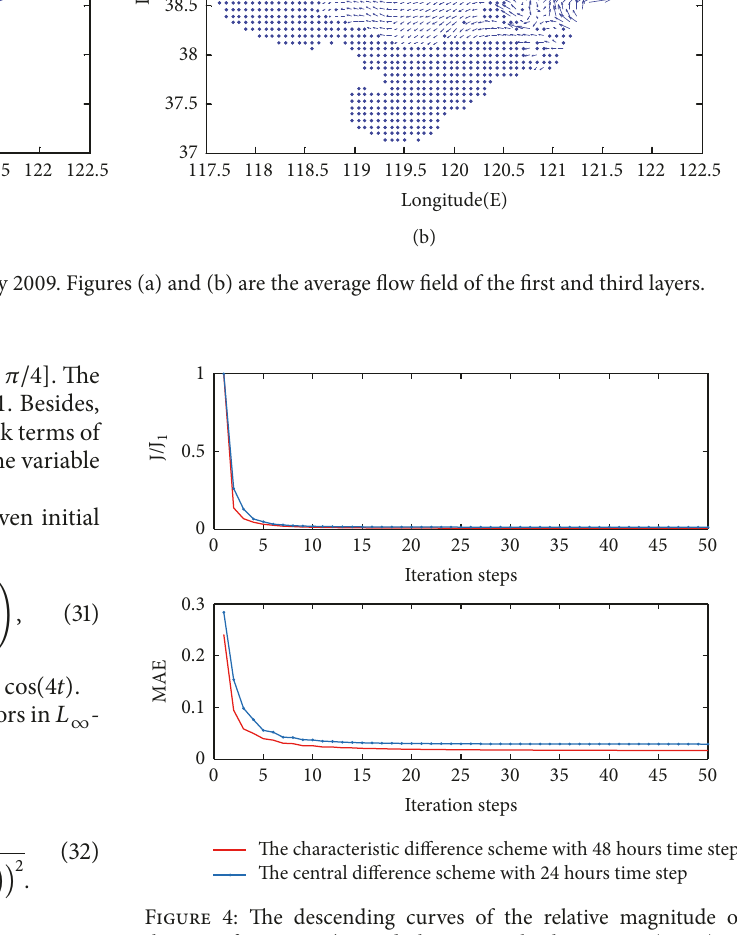
when 𝑁 𝑡 = 300 , the 𝐸 ∞ error and the 𝐸 2 error of CDS are 3.8256 × 10 −1 and 6.6713 × 10 −2 , while the 𝐸 2.4370 × 10 −1 and 4.5245 × 10 −2 when 𝐸 2 error of CFD are = 50 𝑁 𝑡